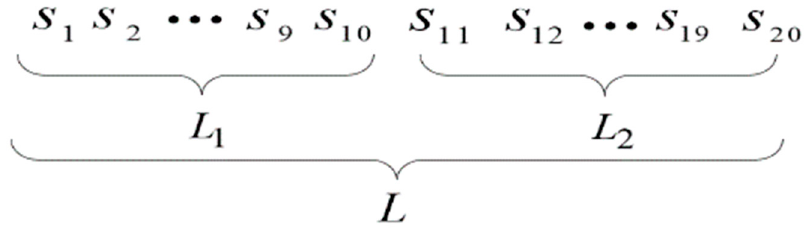
Figure 3. Example of a binary string for the network architecture.